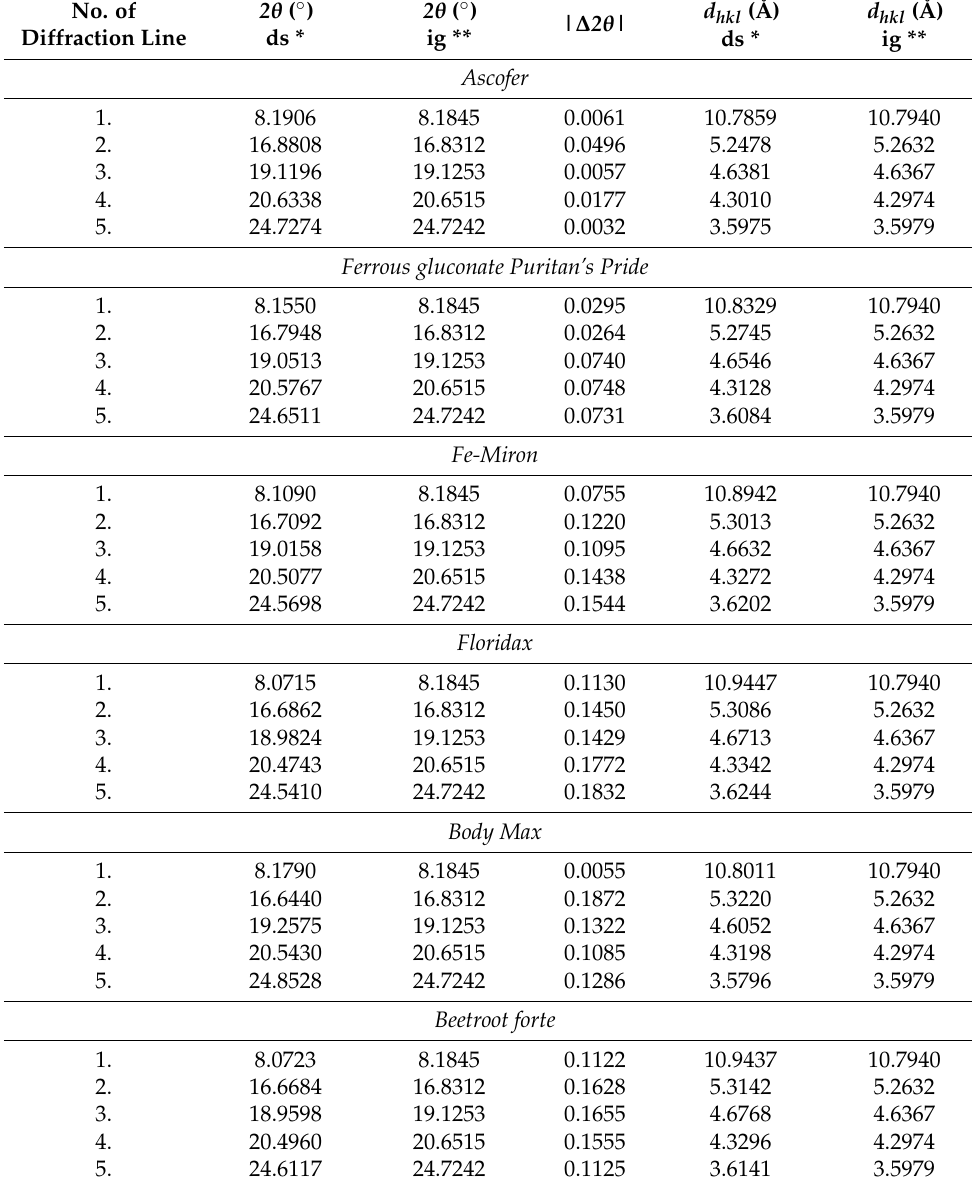
Table 2. Comparison of experimental data of dietary supplements containing iron (II) gluconate with the experimental data for pure iron (II)